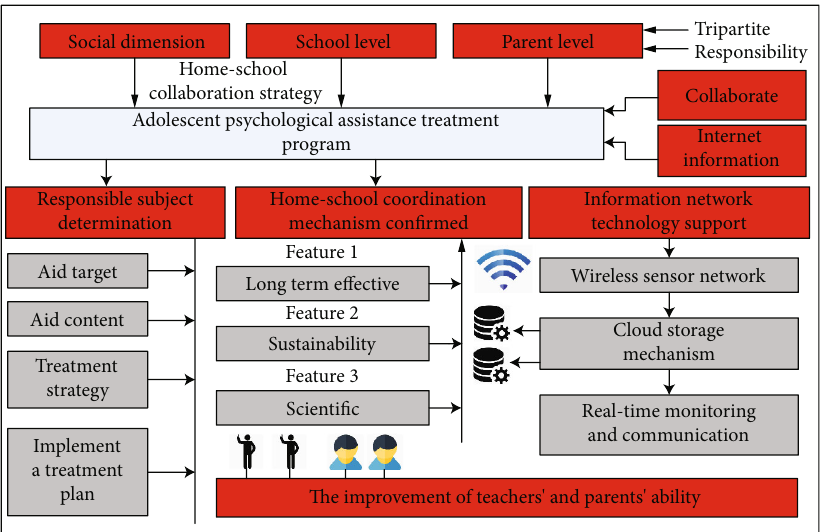
Figure 3: Framework of psychological assistance treatment scheme for adolescents based on network information under the home-school coordination strategy.